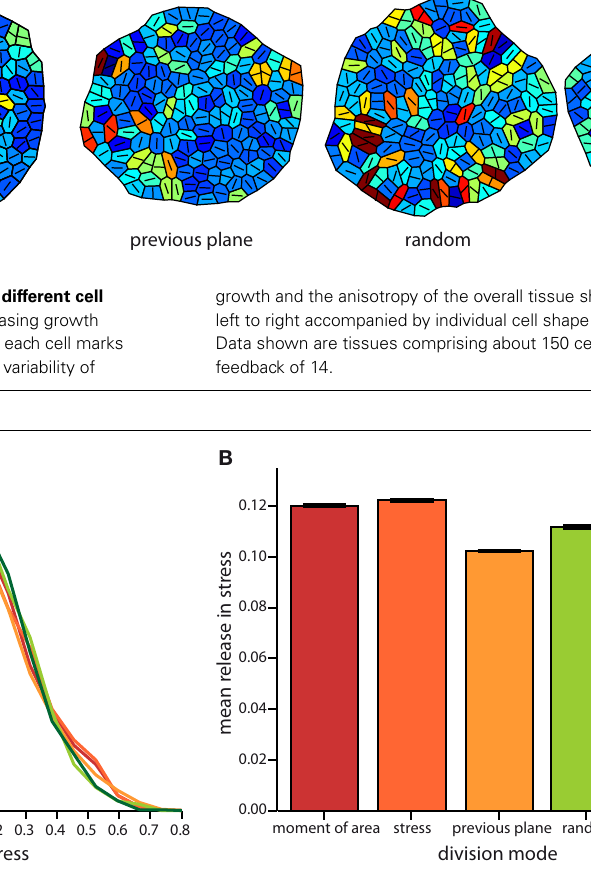
FIGURE 4 | Local release in stress due to the different cell division modes. (A) Distribution of the total change in stress in the dividing cell and its nearest neighbors. Negative (respectively positive) stress means that stress increases (respectively decreases) following division. Subtle differences in the distribution are revealed in the mean local release of stress shown in (B) . Release is largest for cell division along axis of maximum principal stress and